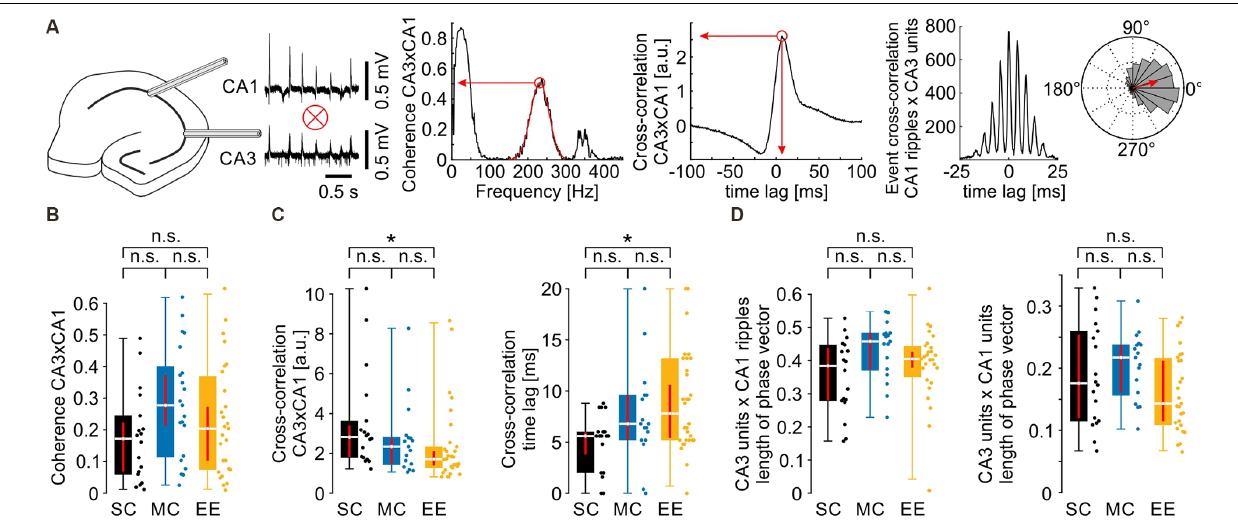
FIGURE 2 | Propagation of network activity from CA3 to CA1 is not affected by environmental enrichment. (A) Schematics of the quantification of different parameters. For the normalized mean phase vector see also Figure 3A . (B) Coherence between CA3 and CA1 in the ripple frequency band was not different between groups. (C) Waveform cross-correlation between CA3 and CA1 showed differences between SC and EE but not between MC and EE or SC and MC. (D) CA3 unit to CA1 ripple (left) and CA3 unit to CA1 unit (right) phase coupling was not different after environmental enrichment. N = 23 slices from six mice for standard conditions, N = 25 slices from five mice for motor control, and N = 39 slices from eight mice for environmental enrichment. Asterisks denote p -values < 0.05 from post-hoc testing followed by a significant Kruskal-Wallis test. Red lines depict the confidence intervals of the median assessed by bootstrapping. n.s., not